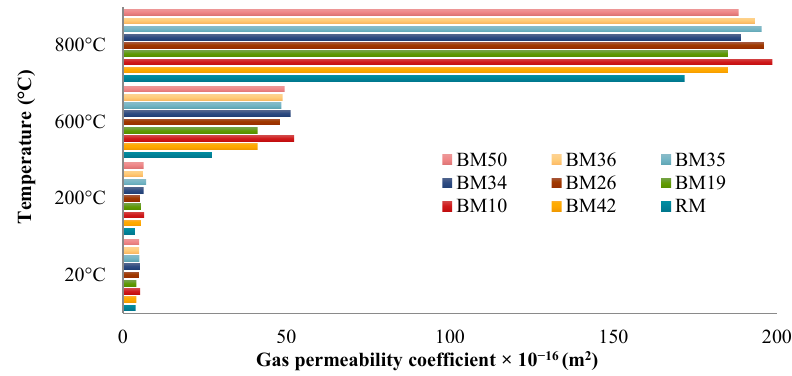
Figure 15. Residual ultrasonic pulse velocity.